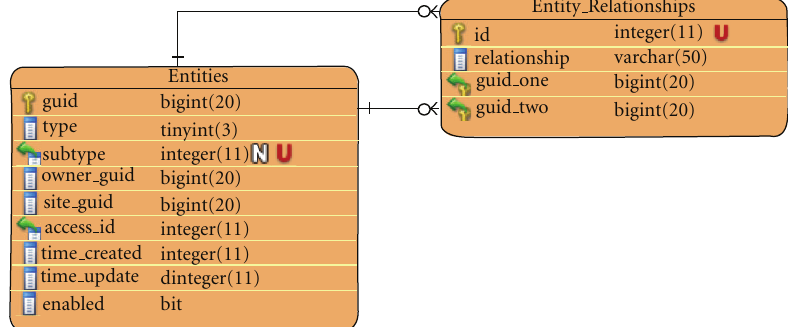
Figure 8: The tables “Entities” and “Entity Relationships.”